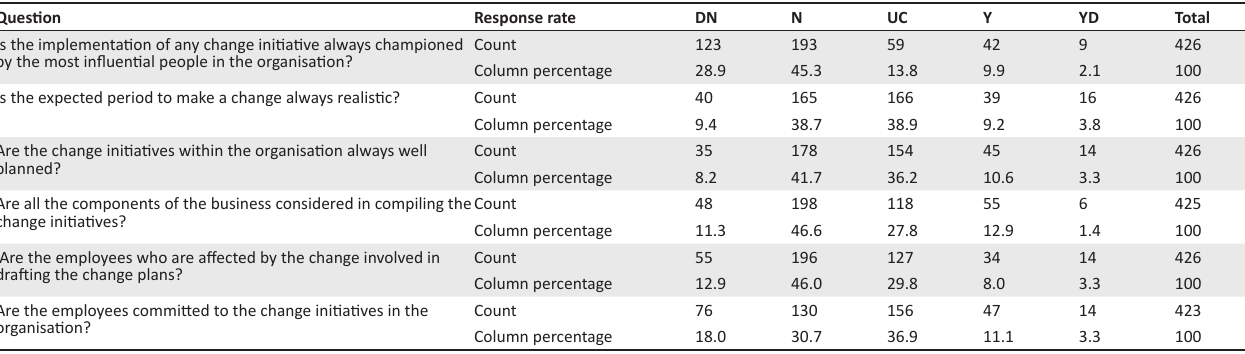
TABLE 9: Change leadership and interventions.